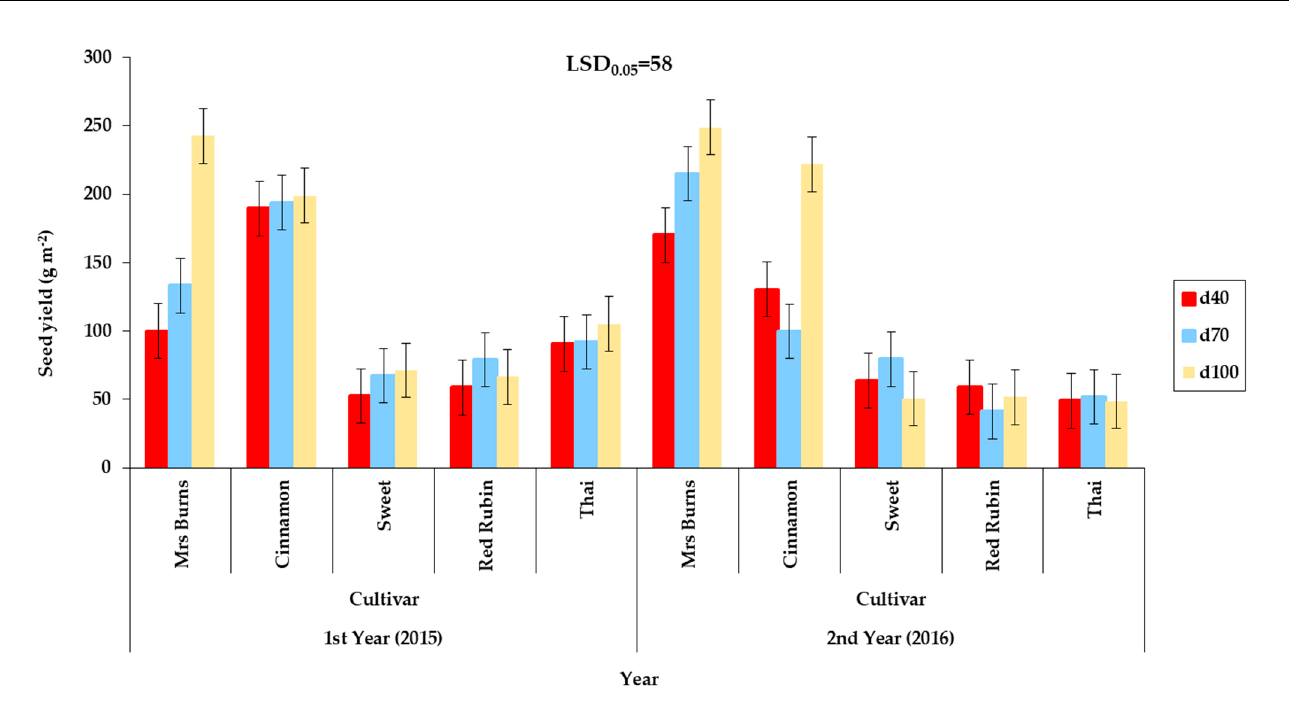
Figure 1. Seed yield of the five basil cultivars (“Mrs Burns”, “Cinnamon”, “Sweet”, “Red Rubin” and “Thai”), at the three irrigation levels, where 40%, 70%, and 100% of the net irrigation requirements (IR n ) are presented as d 40 , d 70 and d 100 respectively, at the two years of experimentation. Data presented are estimated mean values, where LSD is the least significant difference at the 0.05 significance level. Error bars correspond to the estimated common standard error of the mean values. Each mean value has been estimated utilizing n = 4 measurements. Figure S1 (see Supplementary material) presents the observed mean values and the corresponding individual standard errors.